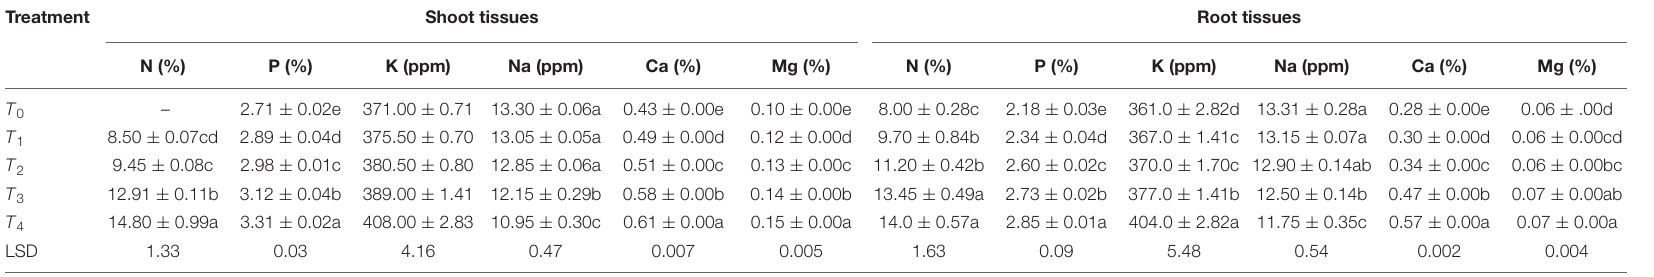
Different letters in the same column indicate significant differences among the means at P = 0.05; LSD, least significant